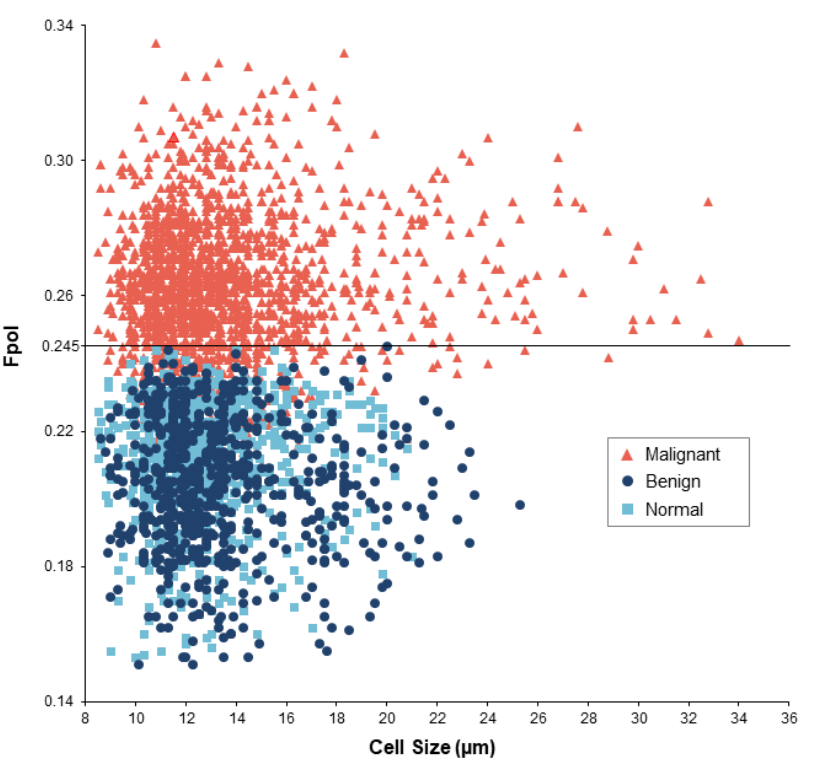
Figure 5. MB Fpol versus cell size for 3521 cells in 32 thyroid samples. Red triangles—malignant (1877 cells); dark blue circles—benign (724 cells); light blue squares—normal (920 cells). Black horizontal line represents Fpol value of 0.245.